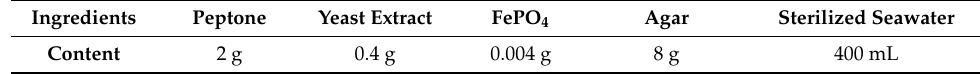
Table 2. Formula of 2216E solid